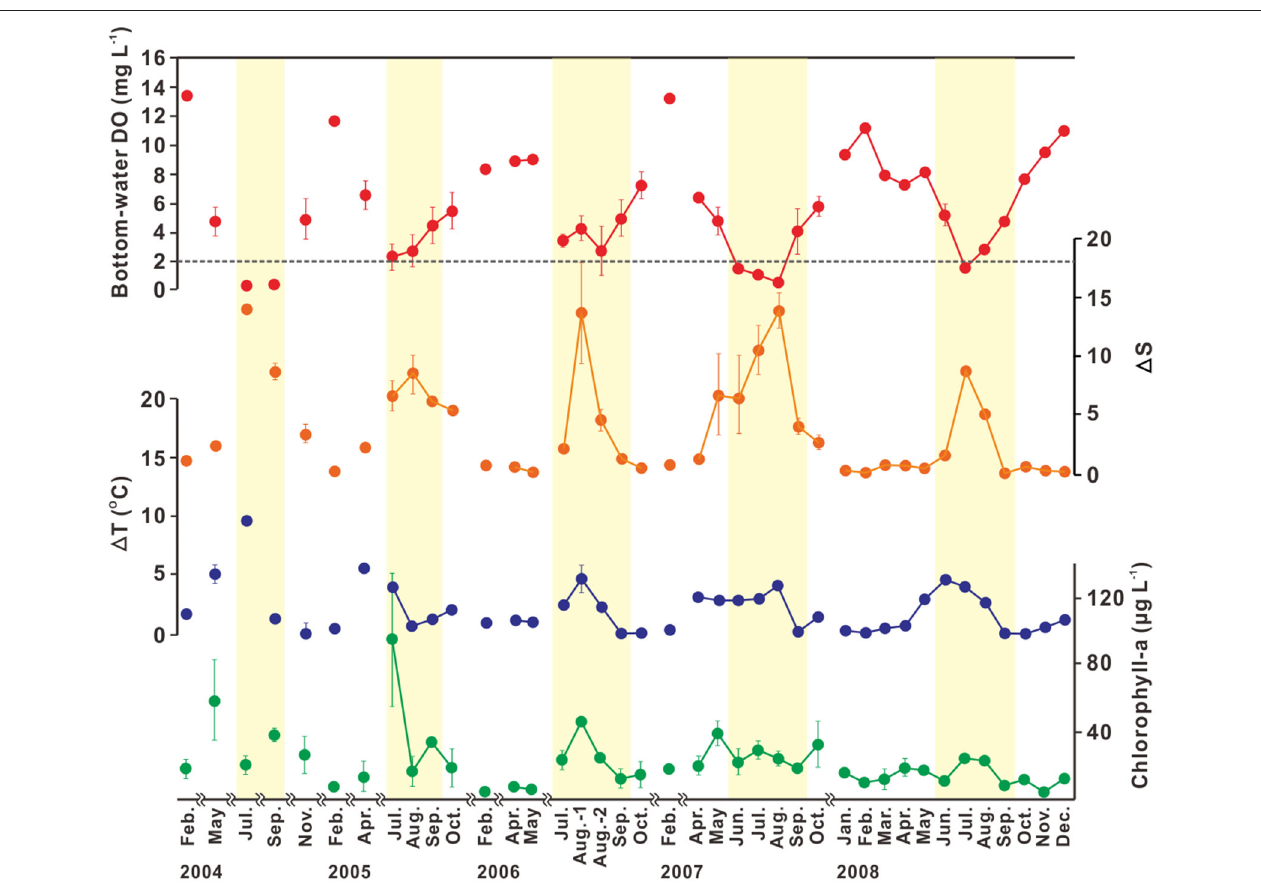
FIGURE 6 | Temporal variation in bottom-water dissolved oxygen (DO; mg L − 1 ), 1 S (i.e., the difference between surface and bottom salinity), 1 T (i.e., the difference between surface and bottom temperatures; ◦ C), and surface chlorophyll-a concentration ( µ g L − 1 ) observed during 2004–2008 in Shihwa Bay. Error bars indicate the standard deviations from the mean. The dotted line in bottom-water dissolved oxygen represents hypoxia (DO < 2mg L − 1 ). Yellow shaded areas indicate hypoxic period from June to September. Source: Modified from Yoo (2010). Used with